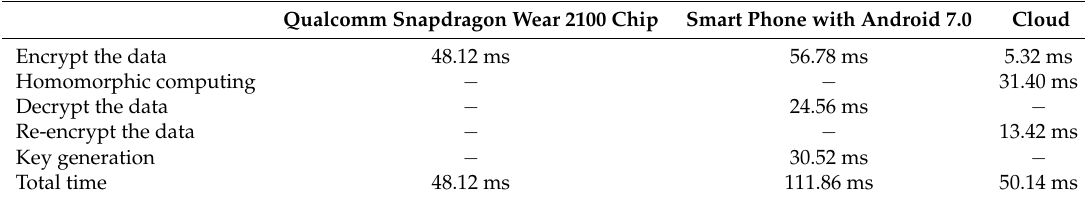
Table 2. FPAS overhead ( n = 1024 bit, | Q | = 2).